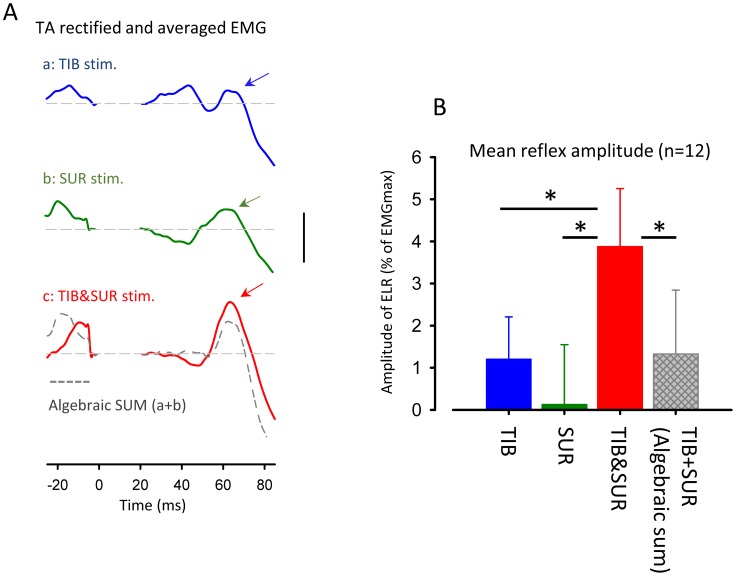
Convergence effect of simultaneous sural and tibial nerve stimulation on TA cutaneous reflex amplitude during ARM&LEG movement.(A) Full-wave rectified and averaged EMG in TA muscle following simultaneous combined stimulation of sural and tibial nerves (TIB&SUR, red trace), sural alone (SUR, green trace) and tibial alone (TIB, Blue trace) obtained from a single subject. Dashed gray trace: the mathematical summation of EMG traces for individual TIB and SUR nerves stimulation (Algebraic SUM). (B) Grand means (± SD) of the magnitudes of early-latency reflex responses (45–80 ms after stimulation onset) following simultaneous combined stimulation of sural and tibial nerves (Red bar), sural alone (Green bar) and tibial alone (Blue bar) obtained from 12 subjects. Hatched gray bar: mathematical summation of reflex amplitude for individual nerve stimulation (TIB+SUR). * p<0.001. Calibration bar = 10 µV.